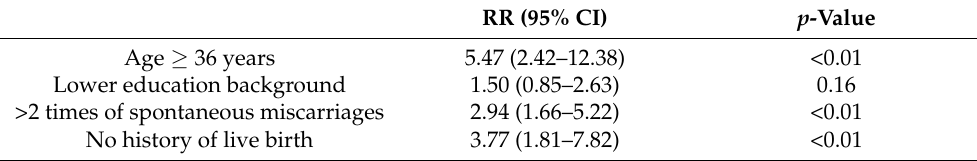
Table 3. Multivariable analysis of risk factors of self-reported depression for RPL